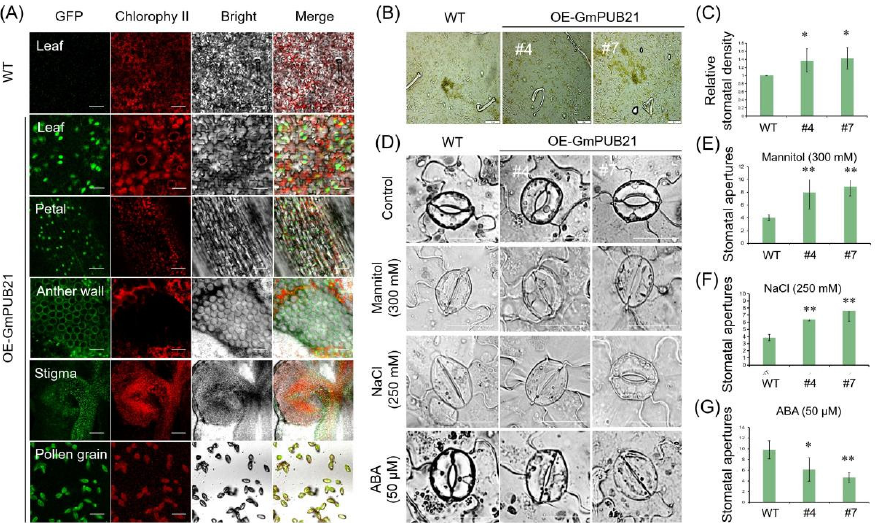
Figure 6. The GmPUB21 effect in the stomatal density and aperture. ( A ) Image of GmPUB21-GFP in transgenic plants at different tissues. Scale bars, 50 µm. ( B ) Image of stomata of transgenic and wild type plants under bright-field microscopy. ( C ) Statistical analysis of stomatal density. The stomatal of WT as standard “1”. Data shown are the means ± SD of three independent experiments. Asterisks indicate statistically significant differences relative to WT (Student’s t -tests, n = 4 plants, * p < 0.05). Scale bars, 20 µm. ( D ) Image of stomata aperture in transgenic and wild type plants under normal condition and drought (300 mM Mannitol) for 3 h, salinity (250 mM NaCl) for 3 h, ABA (50 µM) for 2 h, the average size of stomatal apertures for each genotype, Scale bars, 10 µm. ( E – G ) Stomatal apertures measured under 300 mM Mannitol, 250 mM NaCl, and 50 µM ABA from three replicates, with at least 50 stomatal apertures in epidermal peels measured per replicate. Data shown are means ± SD of three independent experiments. Asterisks indicate statistically significant differences rela- tive to WT (Student’s t -tests, n > 50, * p < 0.05 , ** p < 0.01).